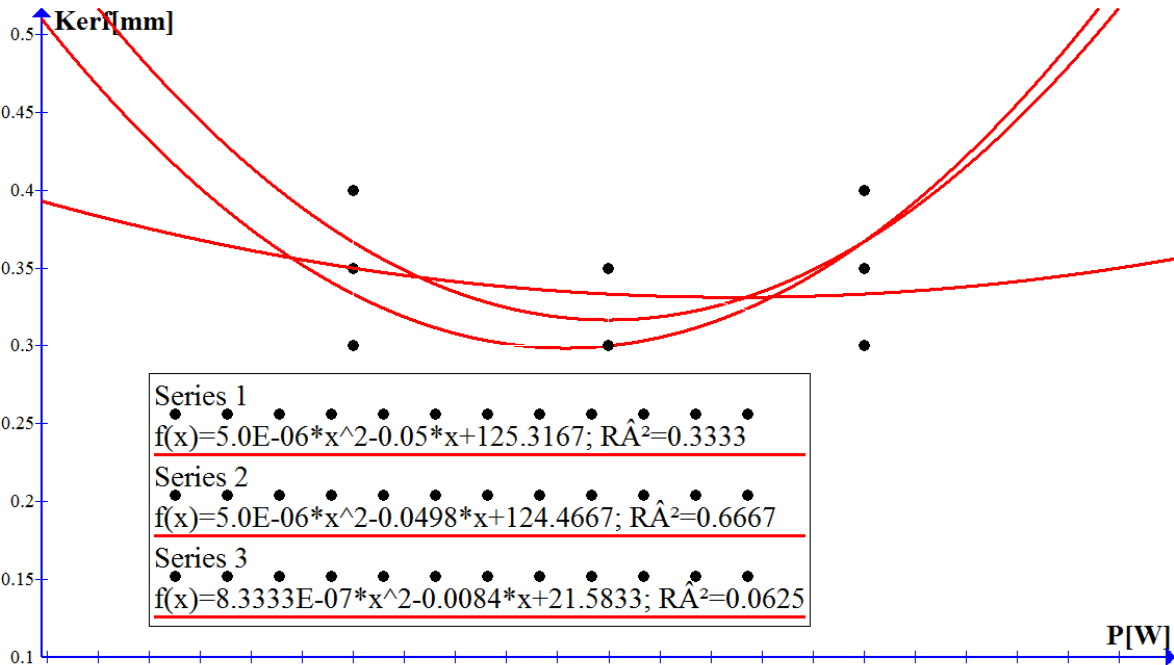
Figure 4. Influence of laser power on cutting width.